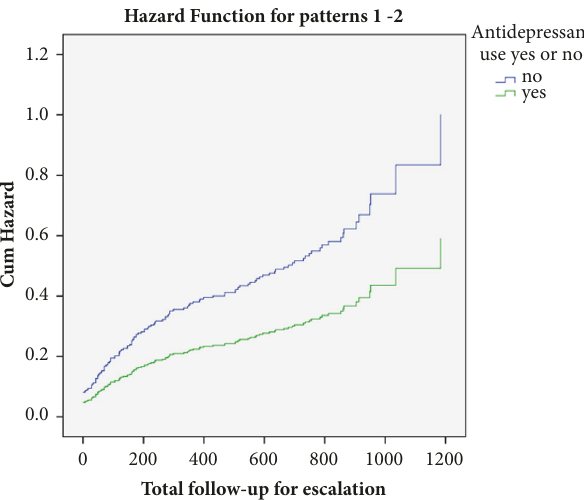
Figure 1: Cumulative hazard for escalation of medical therapy in response to uncontrolled IBD between patients receiving or not receiving